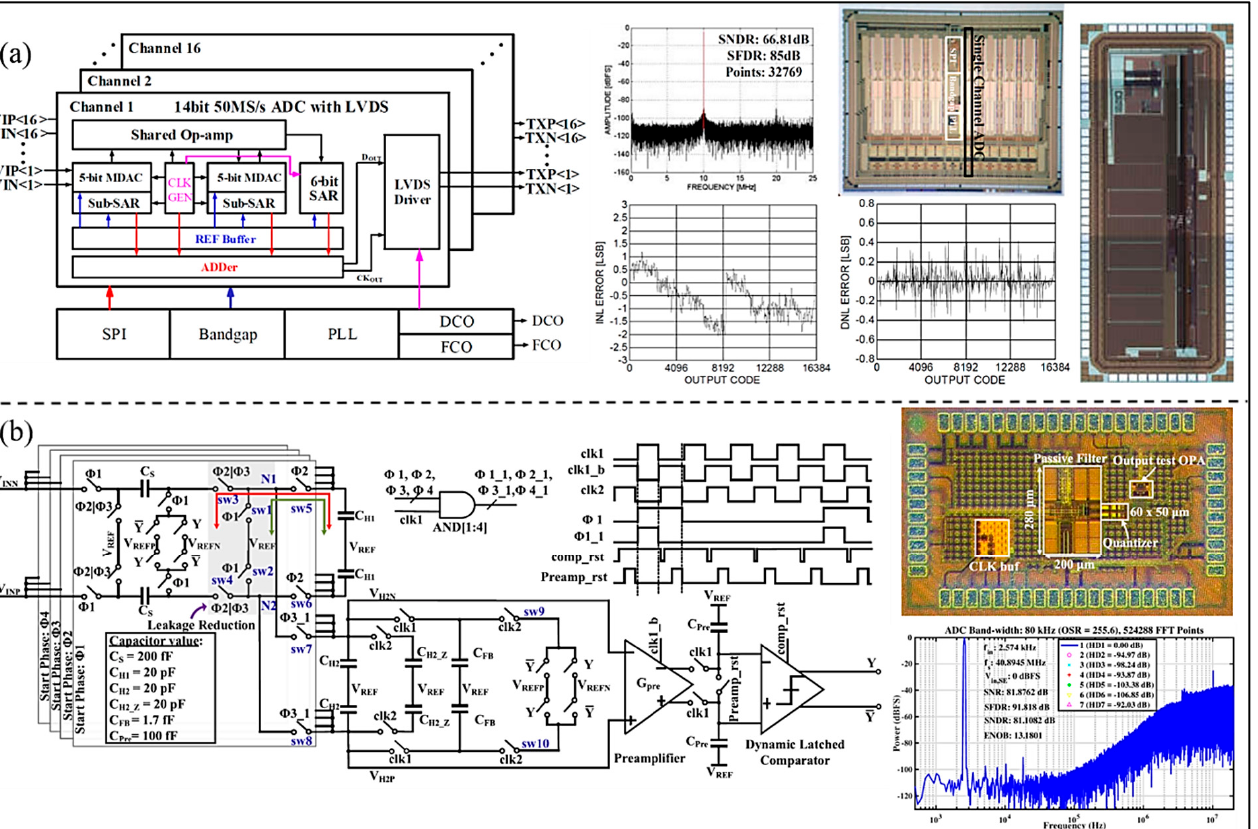
Figure 17. ( a ) Block diagram, layout, and measured results of the proposed ADC. (Reprinted from [65], Copyright 2020, with permission from IEEE); ( b ) Circuit architecture, timing diagram, die, and measured result of the developed ADC. (Reprinted from [66], Copyright 2020, with permission from IEEE).